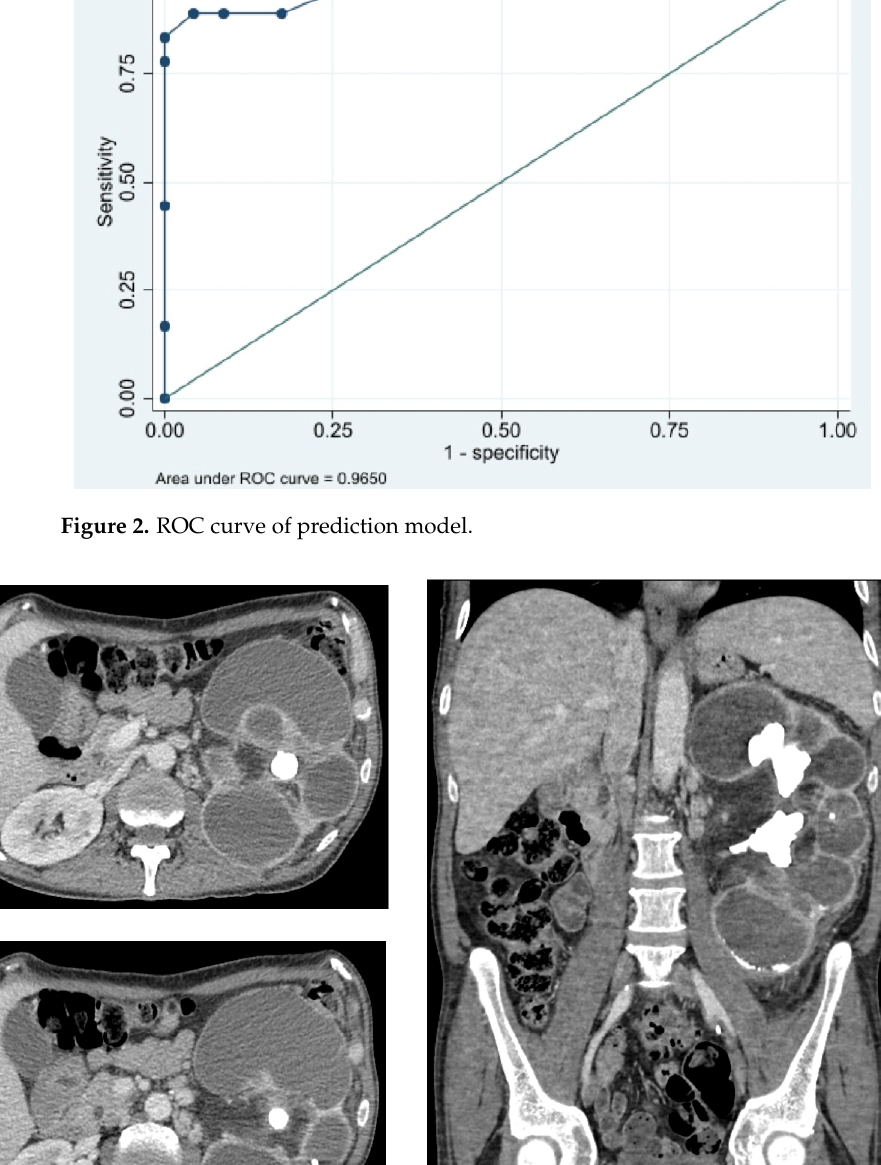
Figure 1. Flow chart of patients included in the study. Among them, 41 cases of in fl ammatory renal diseases were diagnosed: 2 non-functioning hydronephrosis, 1 infected hydro-pyocalix, 4 chronic